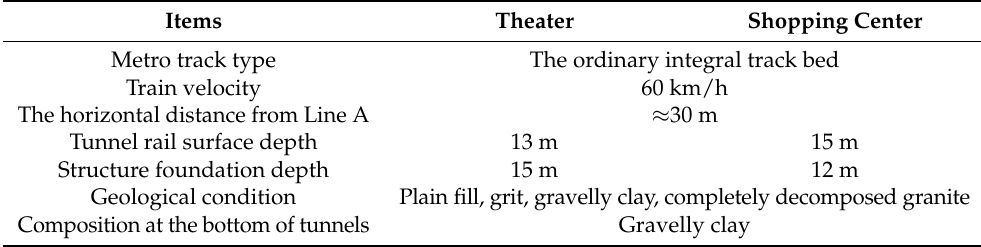
Table 4. Track and geological conditions of the theater and the shopping center. Items Theater Shopping Center Metro track type The ordinary integral track bed Train velocity 60 km/h The horizontal distance from Line A Tunnel rail surface depth Structure foundation